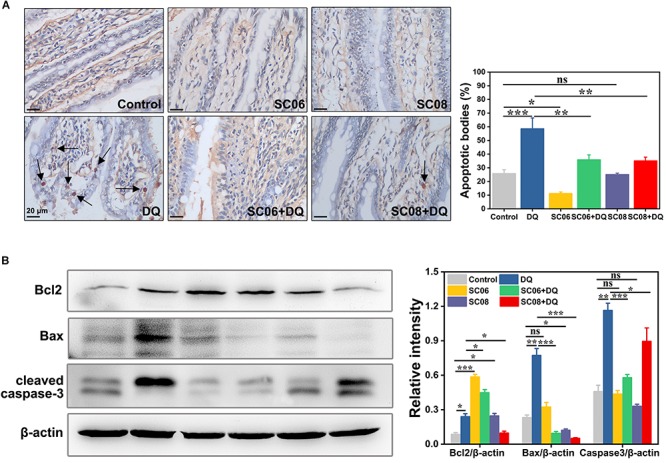
Bacillus protected rats from oxidative stress-induced apoptosis. (A) Jejunal sections from each group were stained with a terminal deoxynucleotide transferase dUTP nick end labeling (TUNEL) kit. Pictures were captured at 400 × magnification, scale bar: 20 μm. The black arrow marks apoptotic bodies (brown puncta). The number of apoptotic bodies were statistically analyzed by Image J. (B) Protein lysates from jejunal mucosa were used to detect the expression of Bcl2, Bax, cleaved caspase-3 by western blot. The ratios of Bcl2, Bax and cleaved caspase-3 to β-actin were analyzed using ImageJ. Data are presented as the mean ± SD (n = 3) using one-way ANOVA with Tukey’s test, ∗p < 0.05, ∗∗p < 0.01, and ∗∗∗p < 0.001; ns, no significance (p > 0.05).